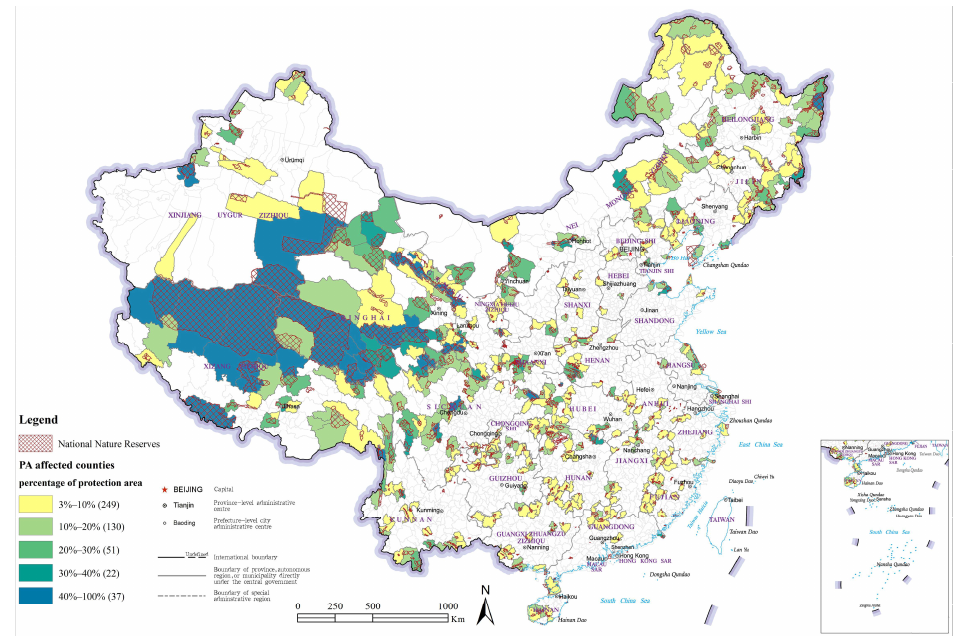
Figure 1. Distribution of research samples.